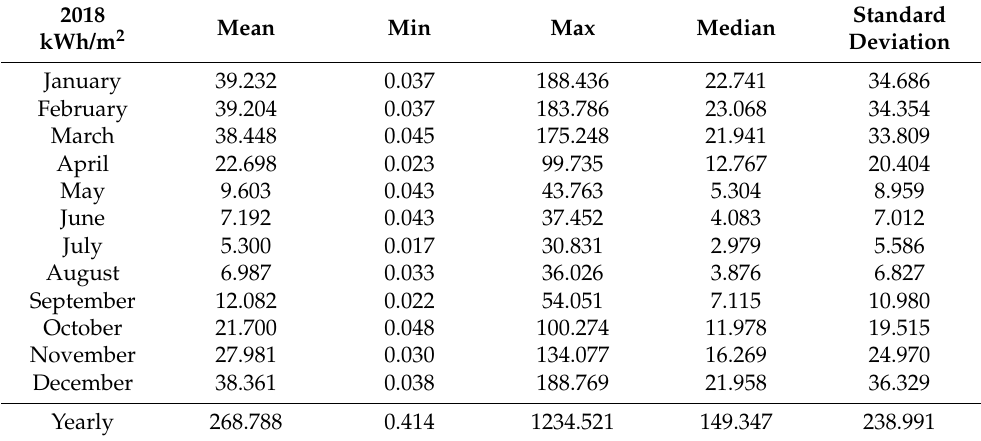
Table 3. District heating demand per month: averages, minimum, maximum and